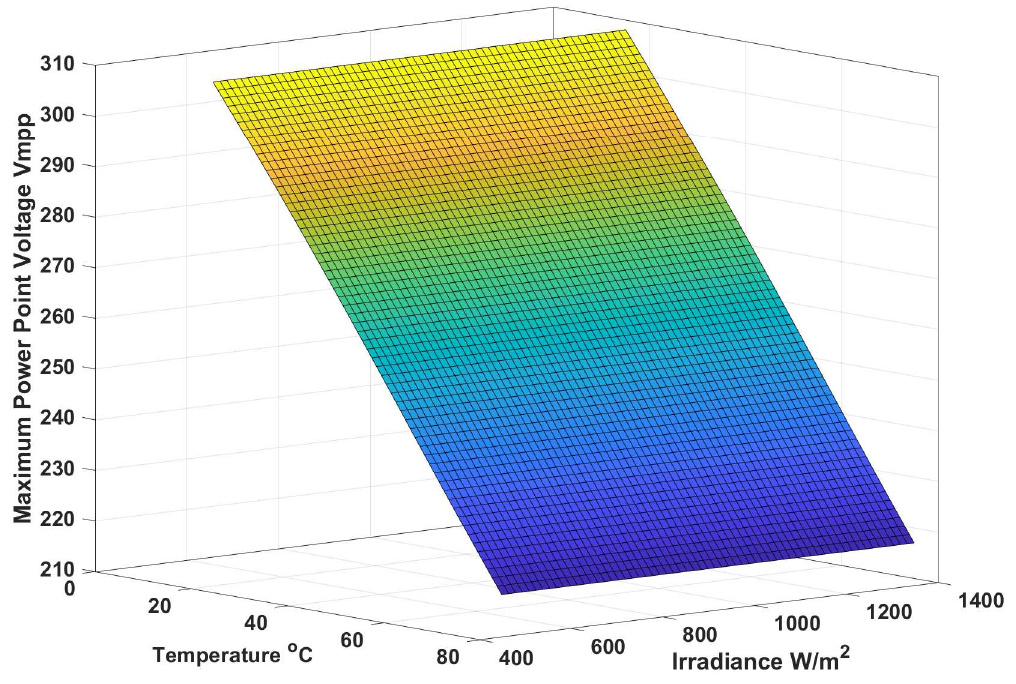
Figure 10. Surface plot of V MPP vs.